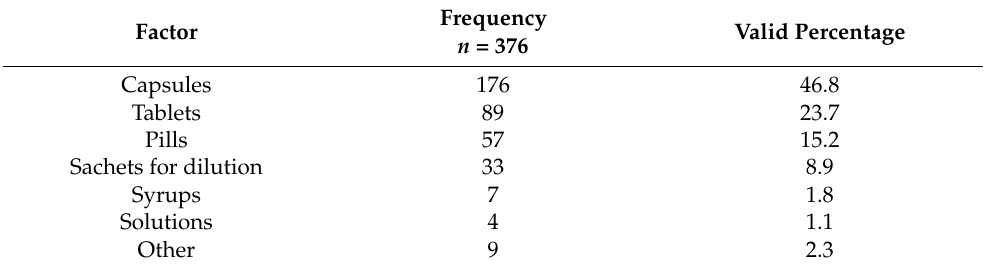
Table 5. Forms of presentation of